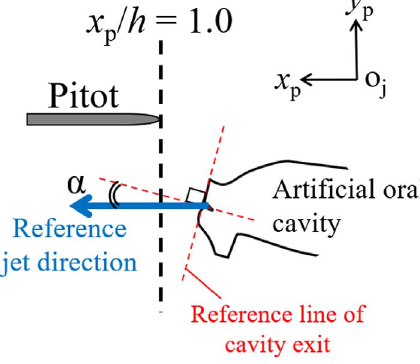
Figure 4. Mean velocity pro fi le of jet measured without fl ute head joint at x p / h = 1.0.